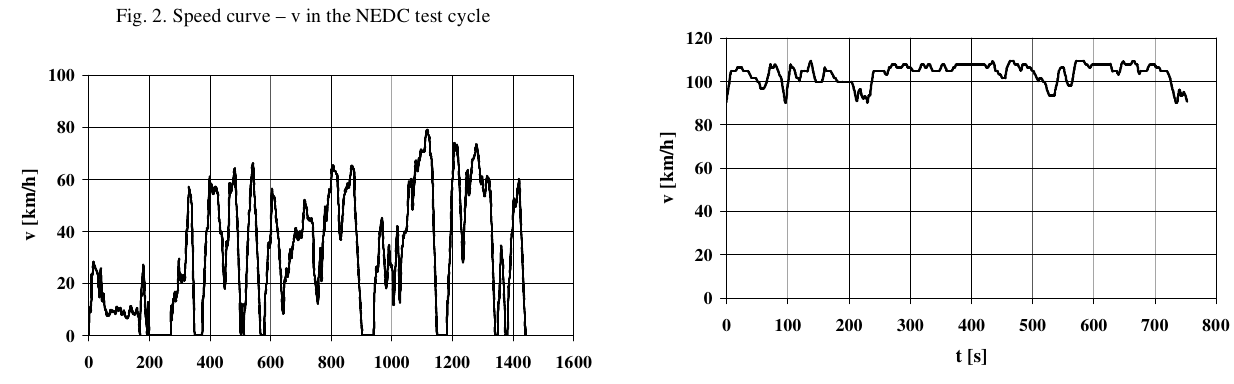
Fig. 6. Speed curve – v in the RDE test cycle performed with a Fiat Idea – drive cycle fragment of the rural drive section – RDE-R